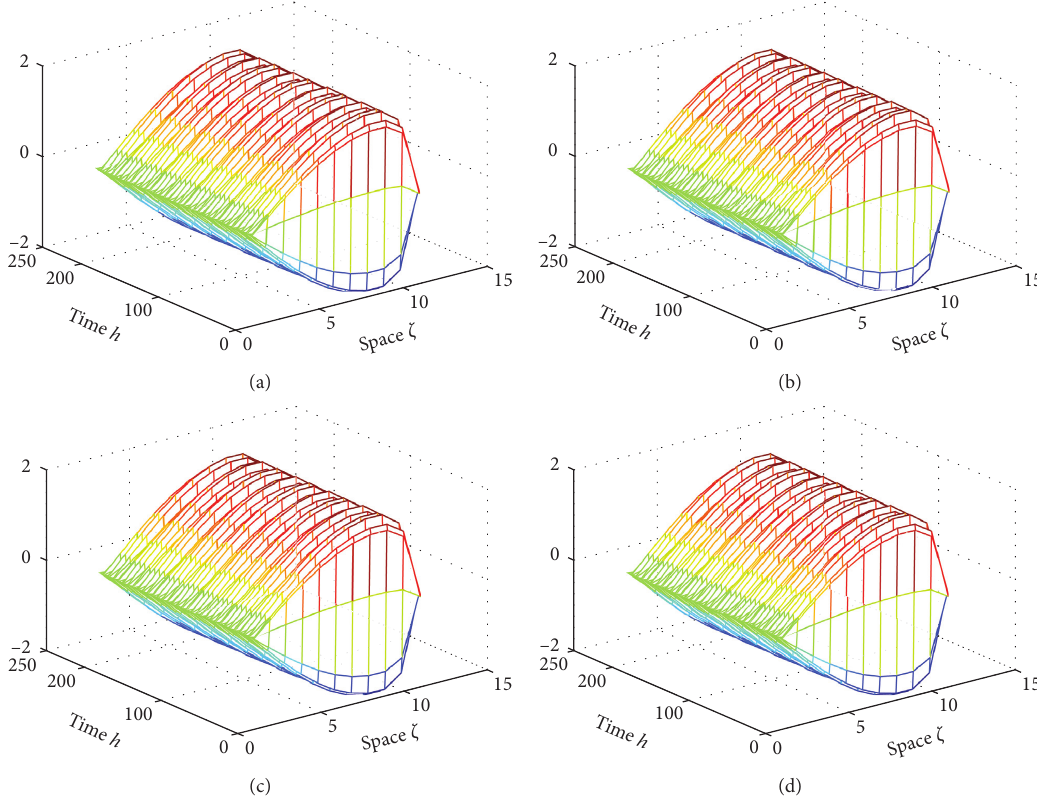
Figure 4: Actual output of three agents and the virtual leader agent in nonlinear parabolic partial MASs. (a) Virtual yτ ( ζ , h ). (b) Agent1 y 1( ζ